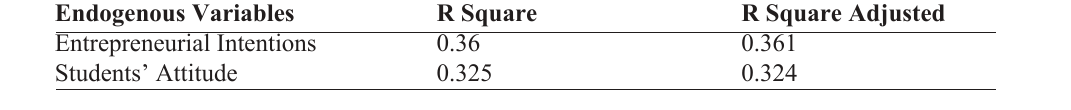
R Square Endogenous Variables R Square R Square Adjusted Entrepreneurial Intentions 0.36 Students’ Attitude